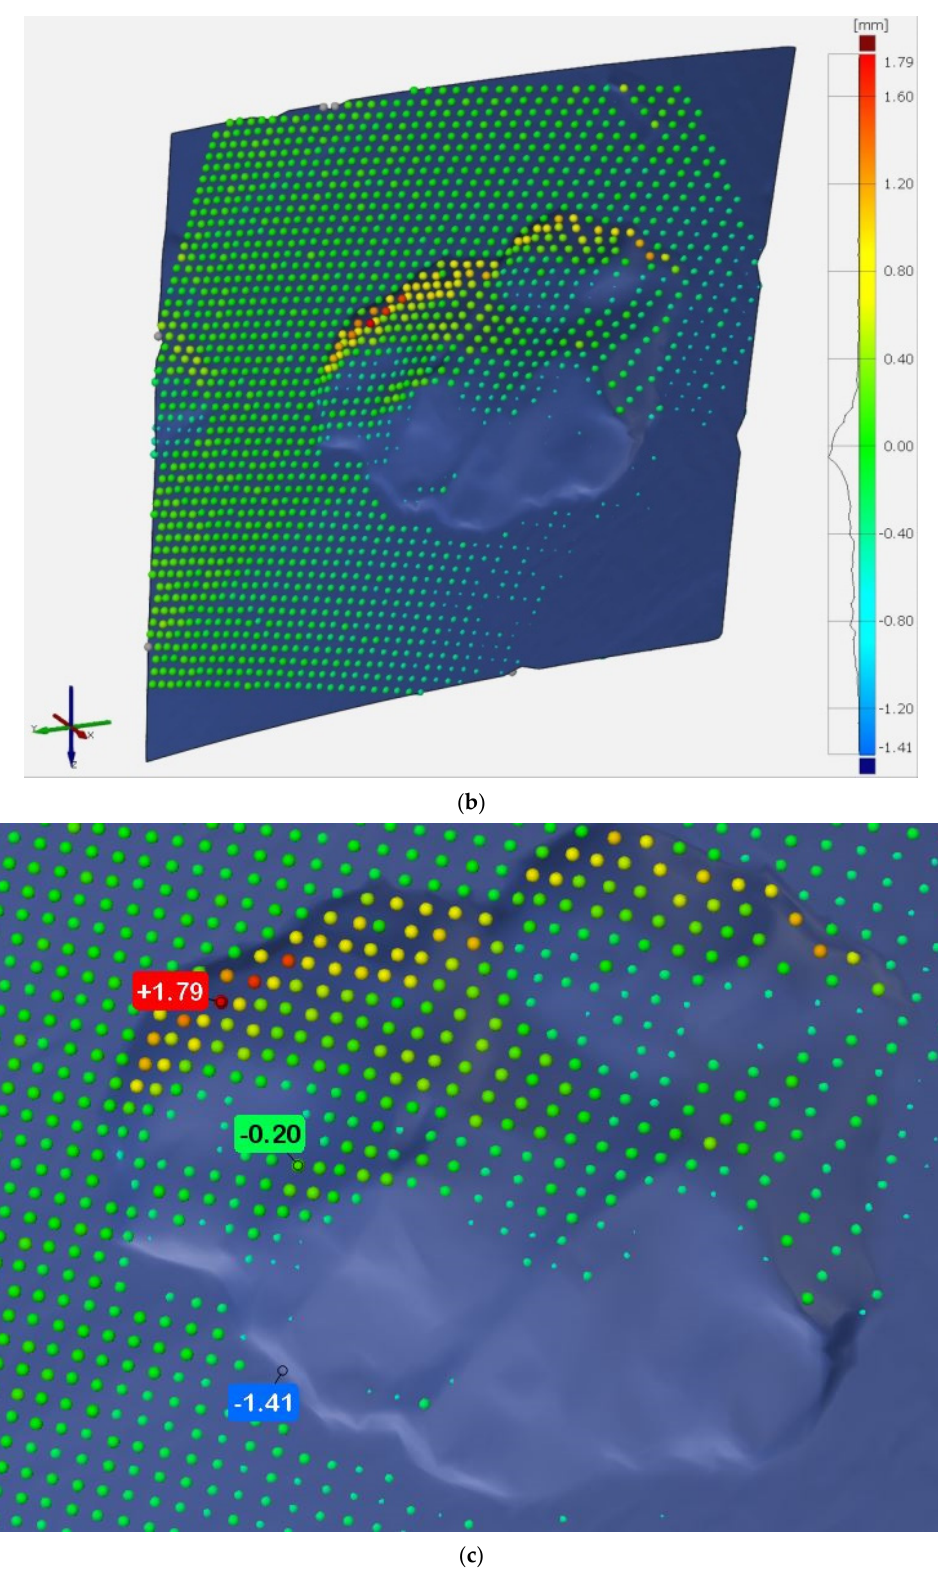
Figure 23. Distribution maps of the distances of measurement points from the cutting head side surface obtained by structural light scanning (reference method): ( a ) view of measurement points from the outer side of the cutting head side surface, ( b ) view of measurement points from the inner side of the cutting head side surface, and ( c ) zoomed-in view of the area of the largest deviation (inner side of cutting head